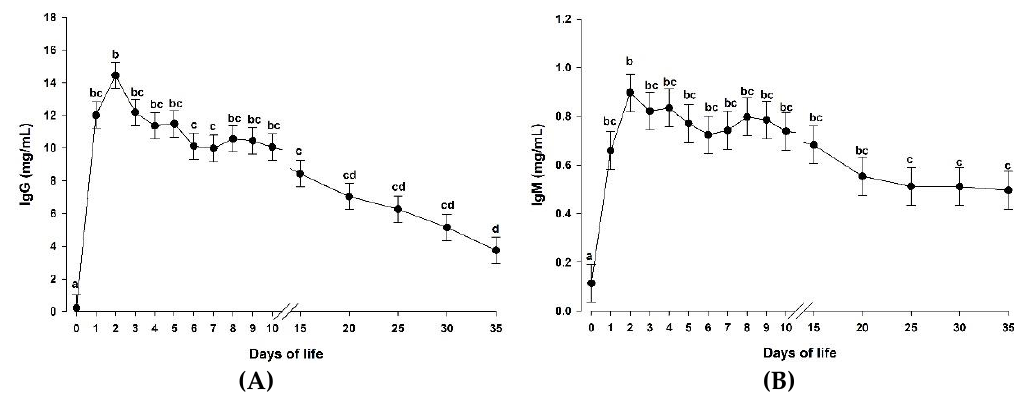
Figure 2. Plasma immunoglobulin G (IgG) concentration (A) and immunoglobulin M (IgM) concentrations (B) in the three groups together (MR-NS, MR-DHA-9 and MR-DHA-18; n = 30) from day 0 to day 35 of life. Different lowercase letters (a-d) indicate significant ( p < 0.05) differences between time points. Results are presented as least squares means ± standard error of the mean. p -values are shown in Table 3. MR-NS: milk replacer without supplementation of a microalgae-derived product rich in DHA; MR-DHA-9: milk replacer with supplementation of 9 g of a microalgae-derived product rich in DHA; MR-DHA-18: milk replacer with supplementation of 18 g of a microalgae-derived product rich in DHA.